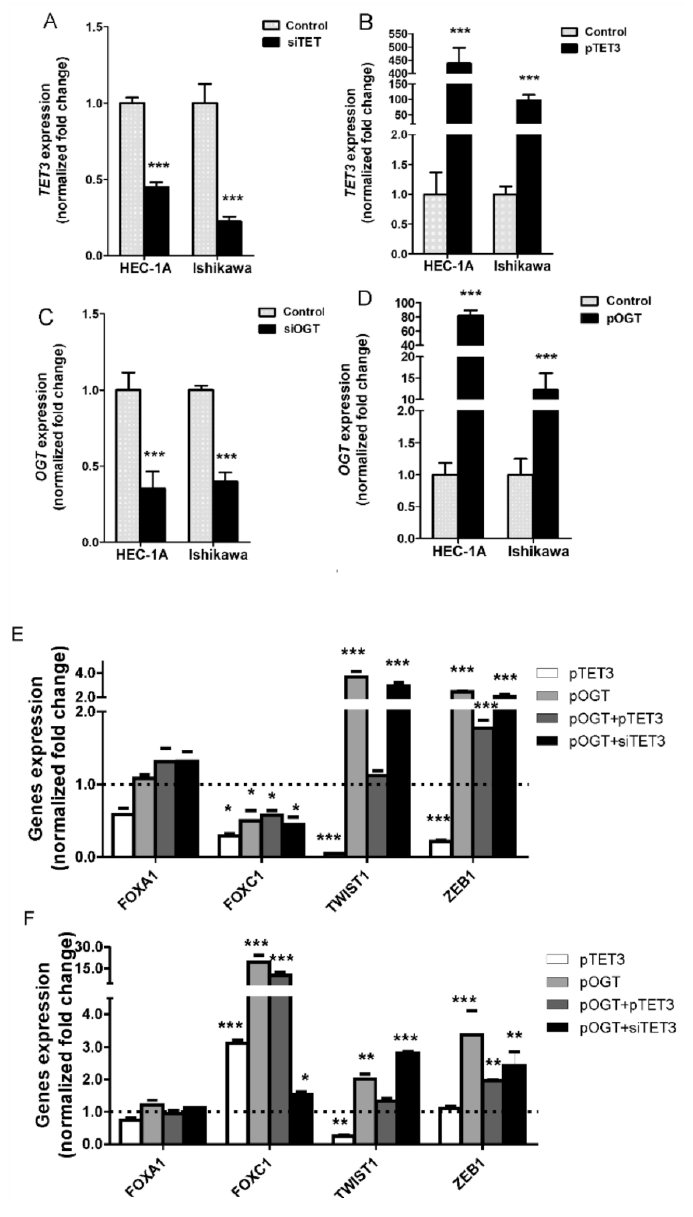
Figure 1. Gene expressions in cells with TET3 and OGT dysregulation. In HEC-1A and Ishikawa cells, TET3 ( A ) and OGT ( C ) expression were decreased by transfection of cells with specific siRNA or increased via transfection with plasmid DNA ( B and D , respectively). The mRNA levels were analyzed by real-time PCR methods (for details see Methods). The mRNA expression of FOXA1 , FOXC1 , TWIST1 , and ZEB1 were evaluated in HEC-1A ( E ) and Ishikawa ( F ) cells with increased expression of TET3 (pTET3), OGT (pOGT), co-expression of OGT and TET3 (pOGT + pTET3), and increased expression of OGT and reduced expression of TET3 (pOGT + siTET3). The expressions of genes in each kind of sample were compared to appropriate controls, i.e., cells treated with empty vectors or nonsilent siRNA duplexes in which expression was assumed to be 1. Data show mean ± SE ( n = 5), * p < 0.01, ** p < 0.001, *** p <